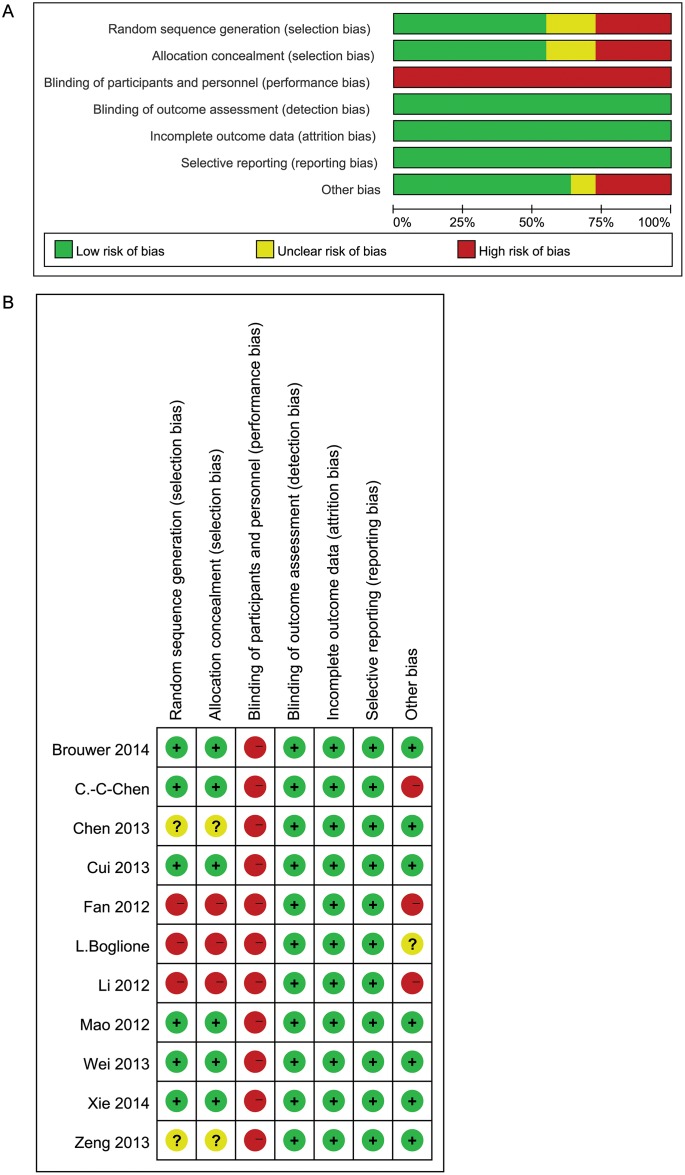
Risk of Bias in the Studies that were included in this Meta-analysis.(A) Review judgments of authors on each methodological quality item presented as percentages across all studies. (B) Review judgments of authors on each methodological quality item for each included study.